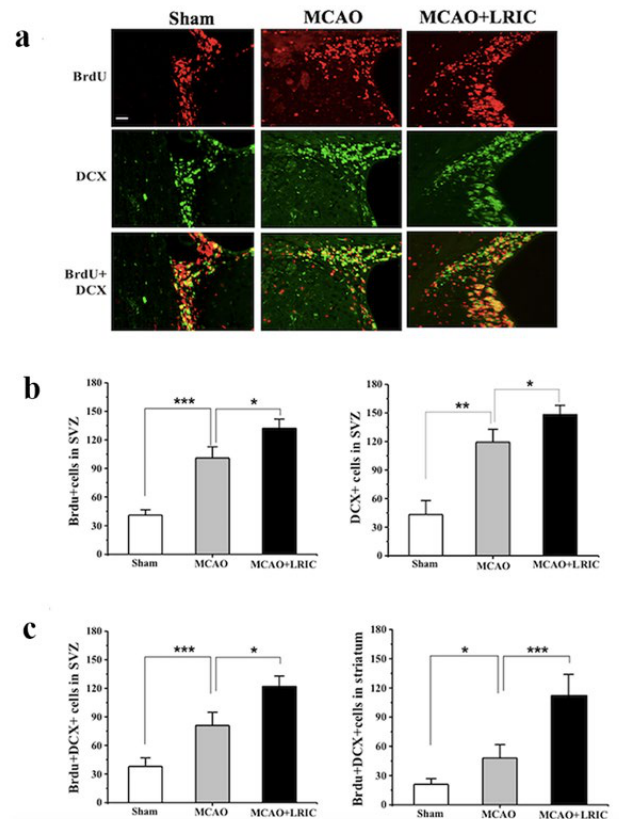
Figure 3. LRIC promoted the proliferation and migration of neural stem cells. ( a ) At day 7 after MCAO, 5 mm thick paraffin embedded sections were used to perform immunohistochemical stain- ing; positive signals in the figure are DCX-positive cells. Immunofluorescence image shows the ex- pression of BrdU (red) and DCX (green) in SVZ at 7 days. Scale bar = 50 mm. ( b , c ) The graph shows the number of BrdU-positive/DCX-positive cells in SVZ and striatum, respectively. Results show mean ± SD, N = 6 per group. * p < 0.05, ** p < 0.01, *** p < 0.001. To investigate the association between the increase in the number of BrdU-positive/DCX- positive cells after LRIC treatment and the neurological function scores, Pearson product regression analysis was used which showed that, after 28 days of LRIC treatment, the neu- rological function score was negatively correlated with the number of DCX-positive/BrdU- positive cells in striatum and SVZ (r 2 = 0.6120, p = 0.0026, r 2 = 0.4679, p = 0.0142, respectively) (Figure 4). The results suggested that the increase in the number of BrdU-positive/DCX- positive cells may be an important part of the recovery of neurological function after LRIC.